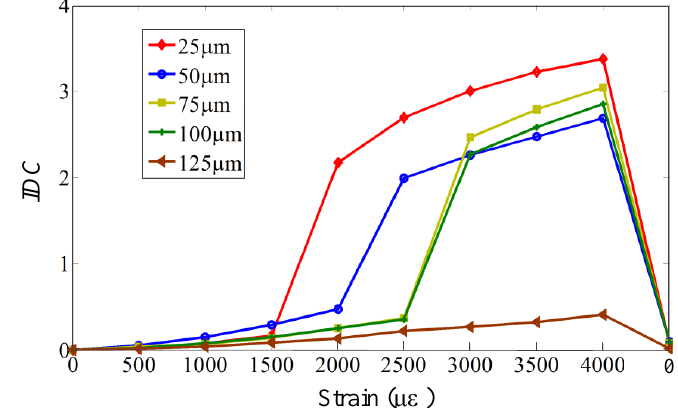
Figure 14. The impedance difference variation with the strain.